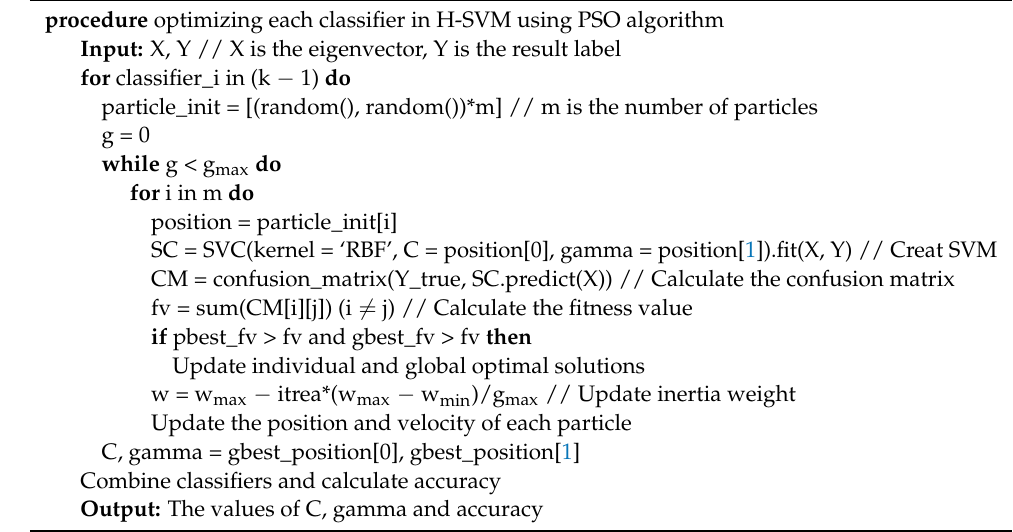
Algorithm 1 Hierarchical Support Vector Machine Based on PSO Algorithm procedure optimizing each classifier in H-SVM using PSO